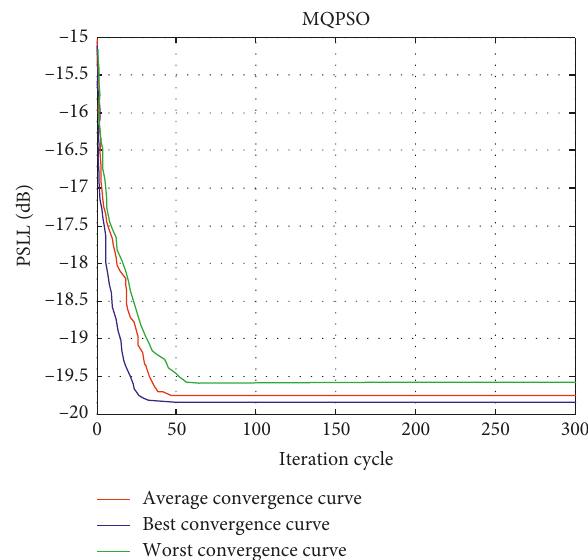
Figure 5: Convergence curve of fitness function. MQPSO for Example 1 optimization.